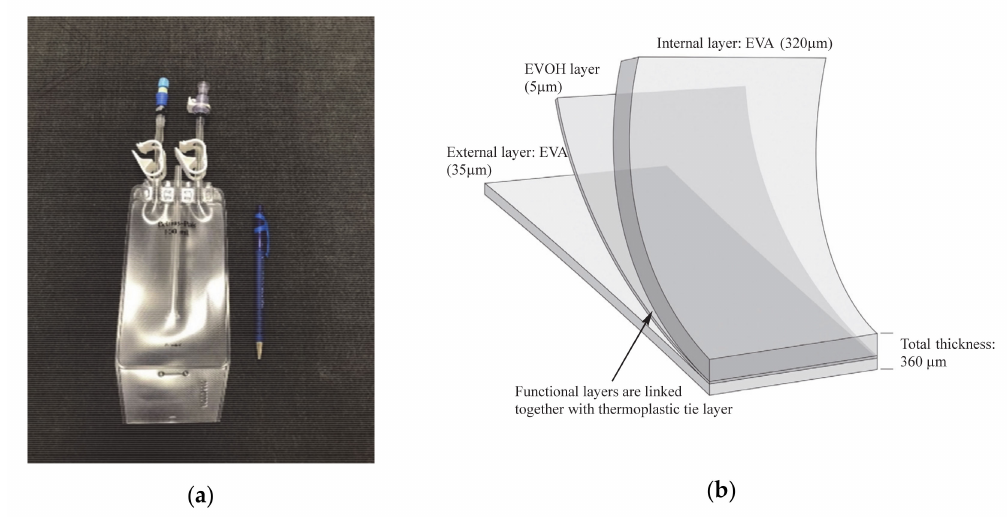
Figure 1. EVA single-use plastic bag ( a ) and composition of the EVA multilayer film ( b